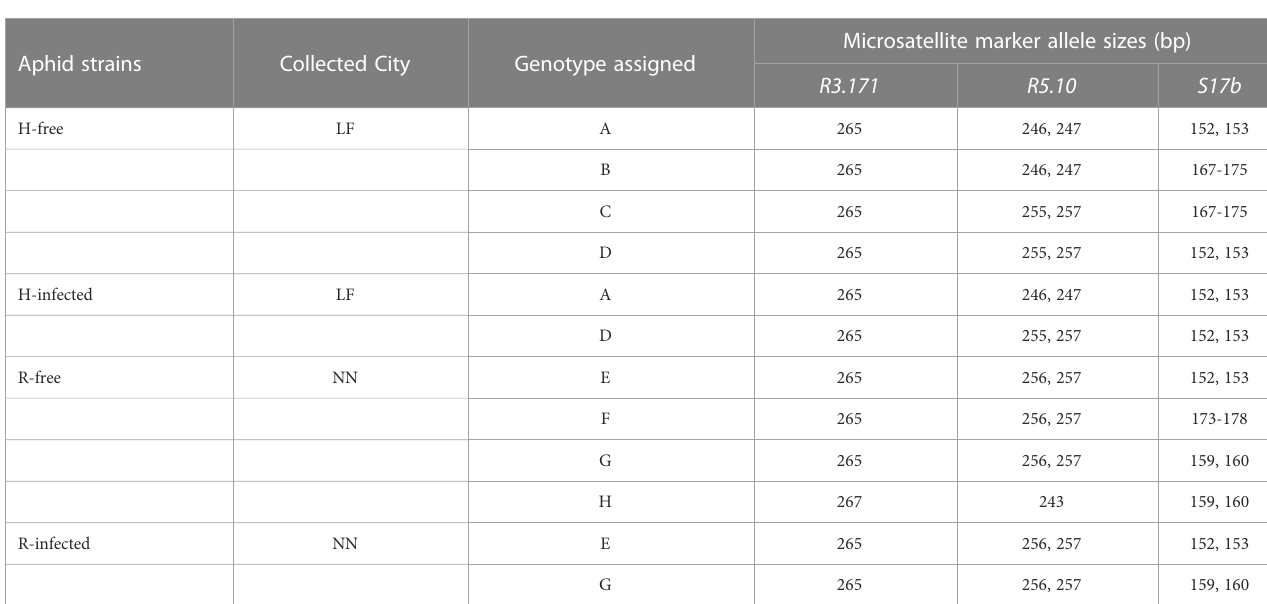
TABLE 2 Genotype and allele sizes of different aphid